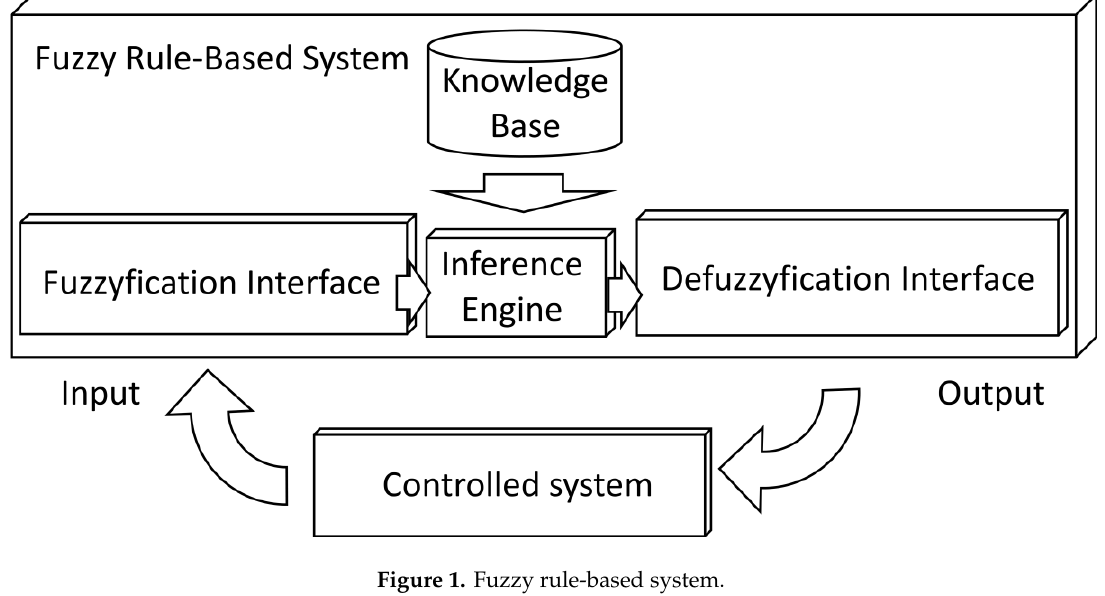
Figure 1. Fuzzy rule-based system.